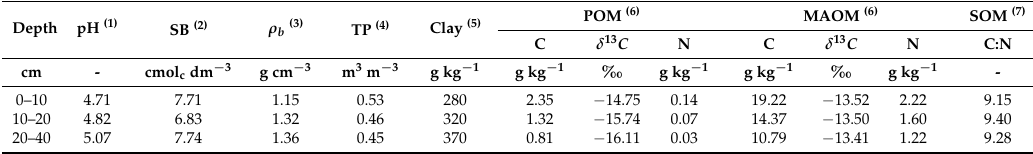
Table 1. Average soil chemical, physical and organic properties at 0–10, 10–20 and 20–40 cm soil depth obtained at the beginning of the experiment in the whole treatment area ( n = 16, for each depth), located in Rio Grande do Sul State, southern